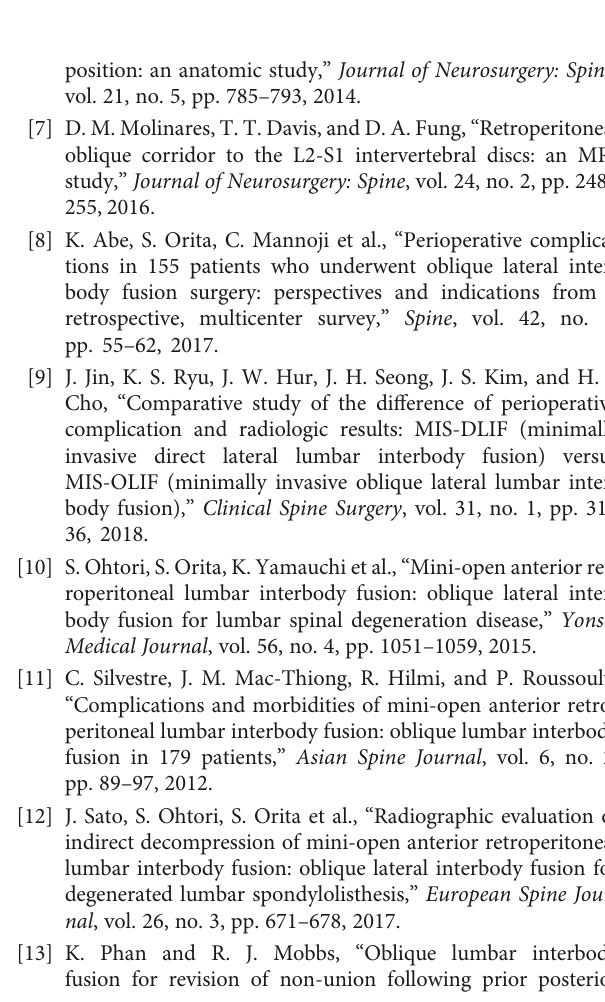
Figure 5: Three months postoperative plain fi lms of lumbar spine AP and lateral (a and b) showed the acceptable position of MIS-OLIF PEEK